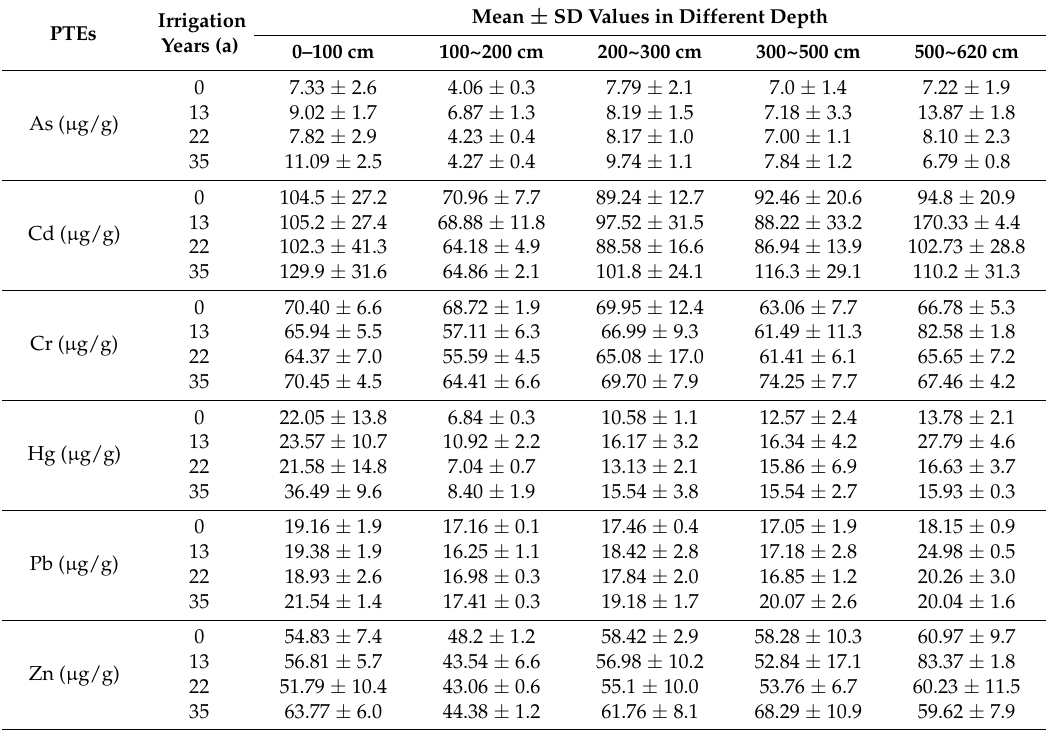
Table 5. Statistical analysis of PTEs in different soil depth with different irrigation